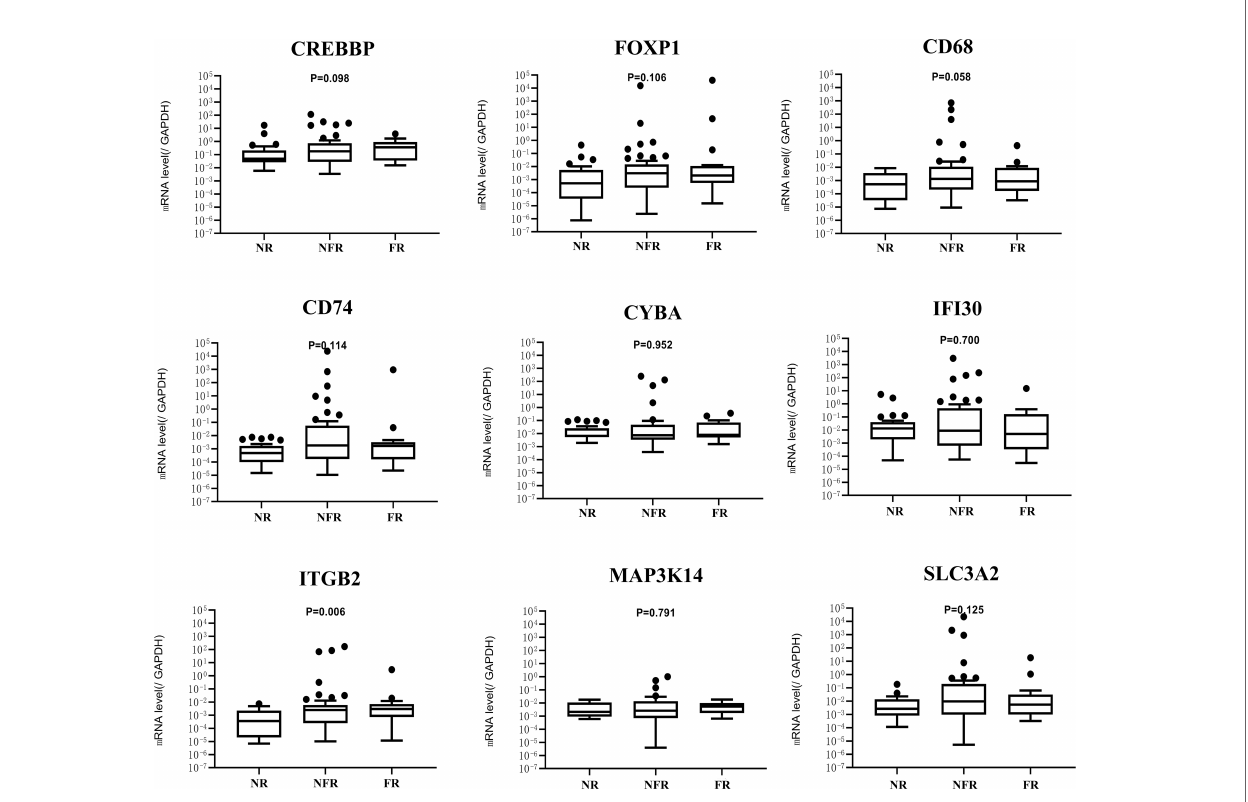
FIGURE 3 | mRNA expression of nine genes in NR ( n = 30),NFR ( n = 43), and FR ( n = 17) groups. NR, no relapse; NFR, non-frequent relapse; FR, frequent